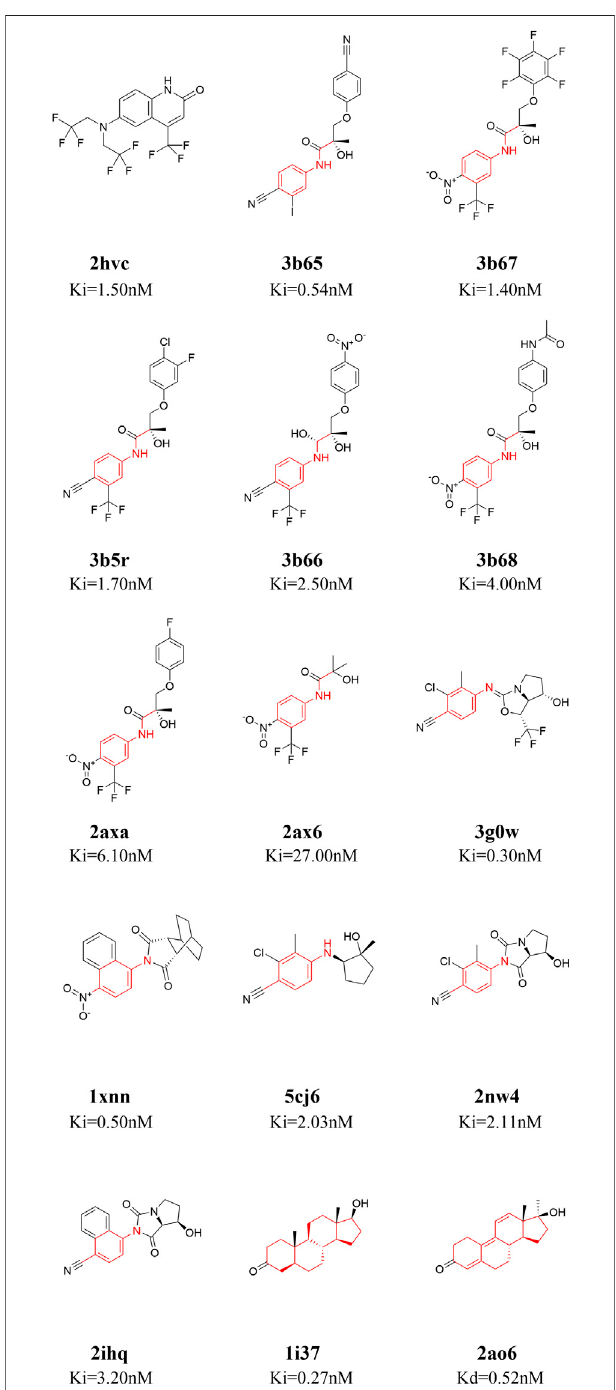
FIGURE 1 | 2D structures of the fi fteen ligands analyzed in this study. The 15 ligands are divided into four categories according to their structural similarity [cluster 1: 2hvc (Wang et al., 2006); cluster 2: 3b65 (Bohl et al., 2008),3b67(Bohletal.,2008),3b5r(Bohletal.,2008),3b66(Bohletal., 2008), 3b68 (Bohl et al., 2008), 2axa (Bohl et al., 2005), 2ax6 (Bohl et al., 2005); cluster 3: 3g0w (Nirschl et al., 2009), 1xnn (Salvati et al., 2005), 5cj6 (Saeed et al., 2016), 2nw4 (Ostrowski et al., 2007), 2ihq (Sun et al., 2006); cluster 4: 1i37 (Sack et al., 2001), 2ao6 (He et al., 2004)], common structures in each cluster are highlighted in